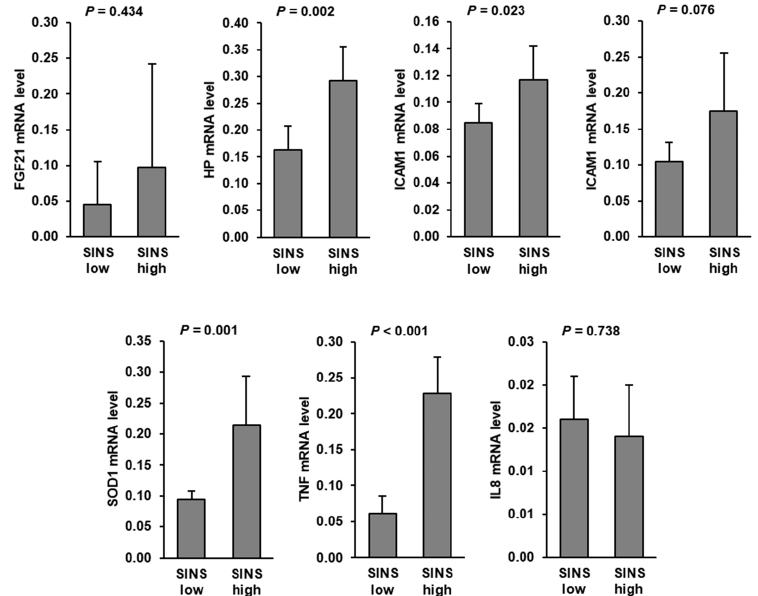
Figure 1. Relative mRNA levels of genes involved in inflammation and stress response in the liver of suckling piglets of the SINS high group and the SINS low group. Data are means ± SD for n = 6 piglets per group. Animals 2021 , 11 , x FOR PEER REVIEW